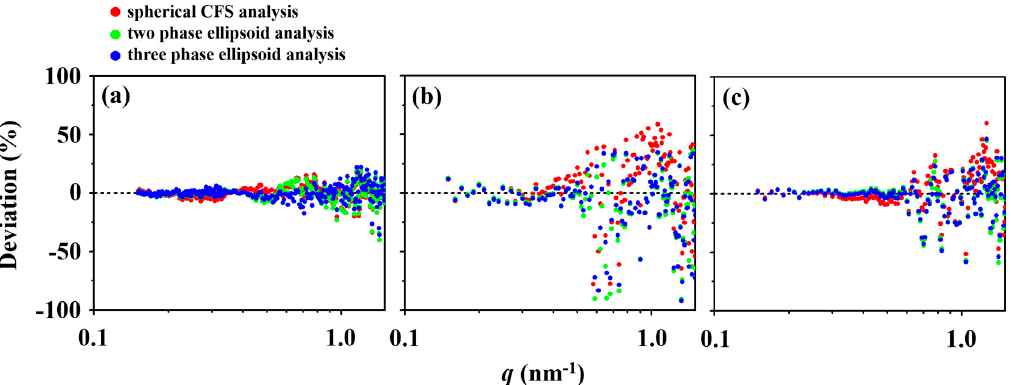
a Micelle radius in the equatorial direction. b Radius of the core. c Thickness of the fuzzy part (interfaced with the dense corona) of the core. d Radius of the corona. e Thickness of the fuzzy part (interfaced with solvent) of the corona. f Thickness of dense corona. g Thickness of the fuzzy part (interfaced with the soft corona) of the dense corona. h Thickness of the solvated corona. i Thickness of the fuzzy part (interfaced with solvent) of the solvated corona. j Ellipsoidicity ratio ( ε = polar Figure 2. A representative X-ray scattering intensity I ( q ) profile and data analysis results of the Figure 2. A representative X-ray scattering intensity I ( q ) profile and data analysis results of the l -PBA- radius/equatorial radius). k Average correlation length of density fluctuation (i.e., blob radius) in the l -PBA- b -PEO micelle formed in deionized water with a concentration of 0.5 wt % at 25 ◦ C, which were b -PEO micelle formed in deionized water with a concentration of 0.5 wt % at 25 °C, which were entire corona region. l Radius of gyration of micelle. m The density of micelle core is assumed to be the performed using ( a ) spherical CFS model, ( b ) two-phase ellipsoid model, and ( c ) three-phase ellipsoid performed using ( a ) spherical CFS model, ( b ) two-phase ellipsoid model, and ( c ) three-phase ellipsoid density of linear PBA homopolymer in films. n Density of corona estimated from the aggregation model. ( d – f ) Kratky representations of the scattering data of the l -PBA- b -PEO micelle fitted by spherical model. ( d , e , f ) Kratky representations of the scattering data of the l -PBA- b -PEO micelle fitted by number of copolymer chains N agg , the number-average molecular weight of the PEO block, and the CFS, two-phase ellipsoid, and three-phase ellipsoid models, respectively. In each figure, the open dot spherical CFS, two-phase ellipsoid, and three-phase ellipsoid models, respectively. In each figure, the total volume of the corona. o Aggregation number of copolymer chains in a single micelle, which was symbols are the measured data and the red solid line represents the sum of the corresponding analysis open dot symbols are the measured data and the red solid line represents the sum of the estimated from the core volume and the assumption that the density of the core composed of PBA profile (blue line) and blob contribution (green line). Here, q = (4 π / λ )sin θ in which 2 θ is the scattering corresponding analysis profile (blue line) and blob contribution (green line). Here, q = (4 π / λ )sin θ in block is same with that of the corresponding ρ core values. angle and λ is the wavelength of the X-ray beam used. which 2 θ is the scattering angle and λ is the wavelength of the X-ray beam used.